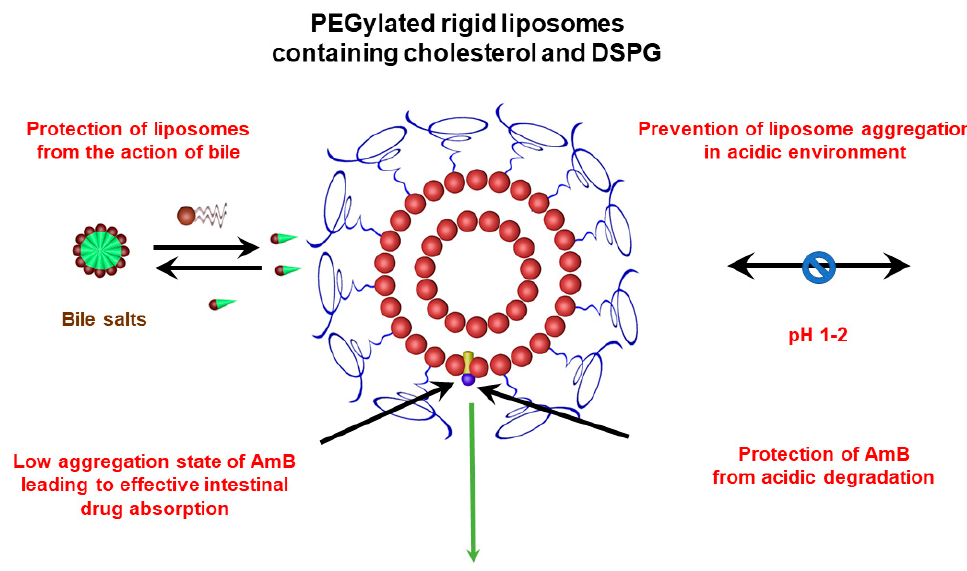
Figure 10. Possible factors contributing to the oral efficacy of PEGylated liposomal AmB formula- tion.